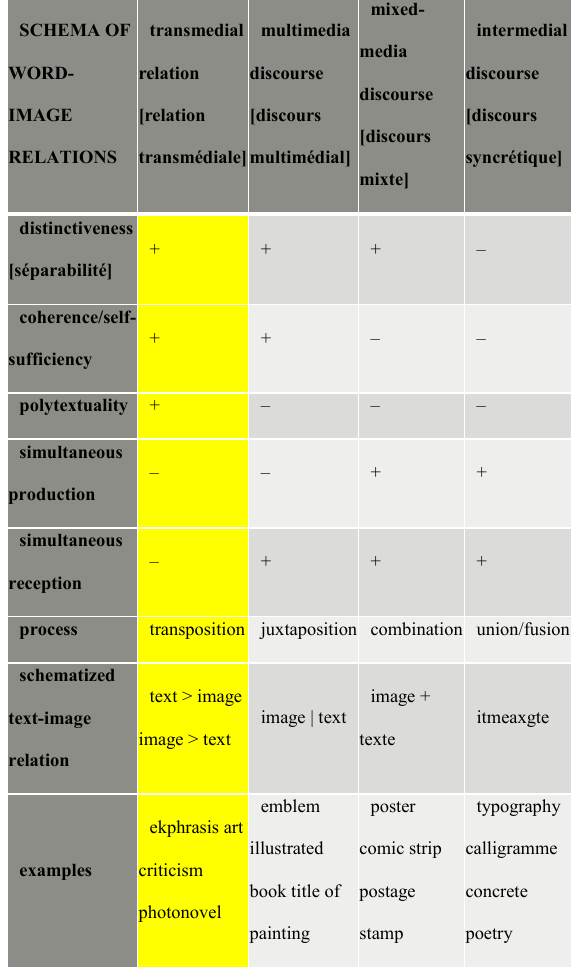
Figure 1. Eric Vos. “The Eternal Network. Mail Art, Intermedia Semiotics, Interarts Studies.” (Ulla-Britta Lagerroth, Hans Lund, and Erik Hedling